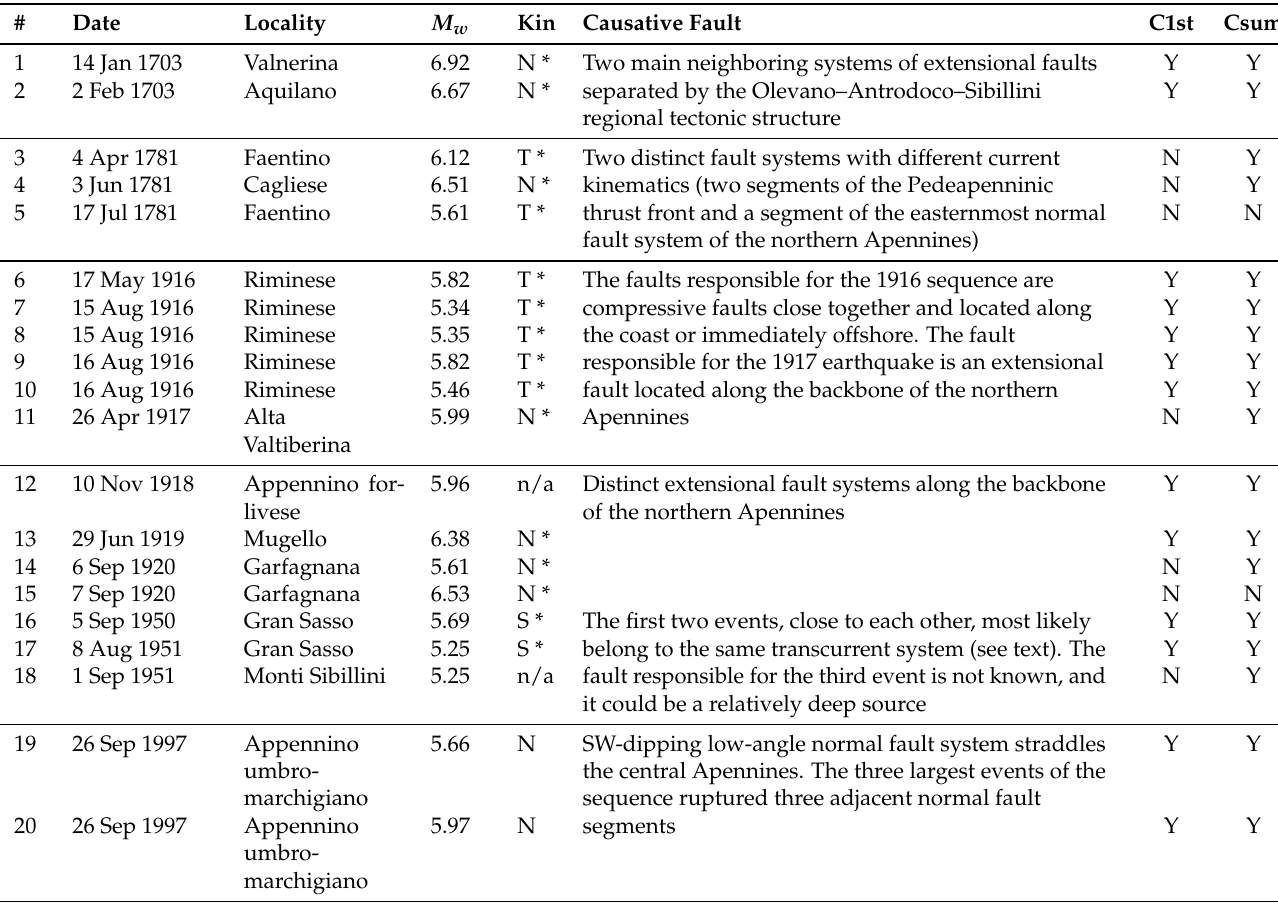
Table 2. Largest sequences in real catalog with at least two main shocks of past 370 years (1650– 2020; magnitude and locality from CPTI15). Results of algorithm for detecting sequences with multiple main shocks in study area are shown in last two columns. Column “Csum” shows results of algorithm applying criterion 4c, while column “C1st” criterion 4a (Y: simulated; N: not